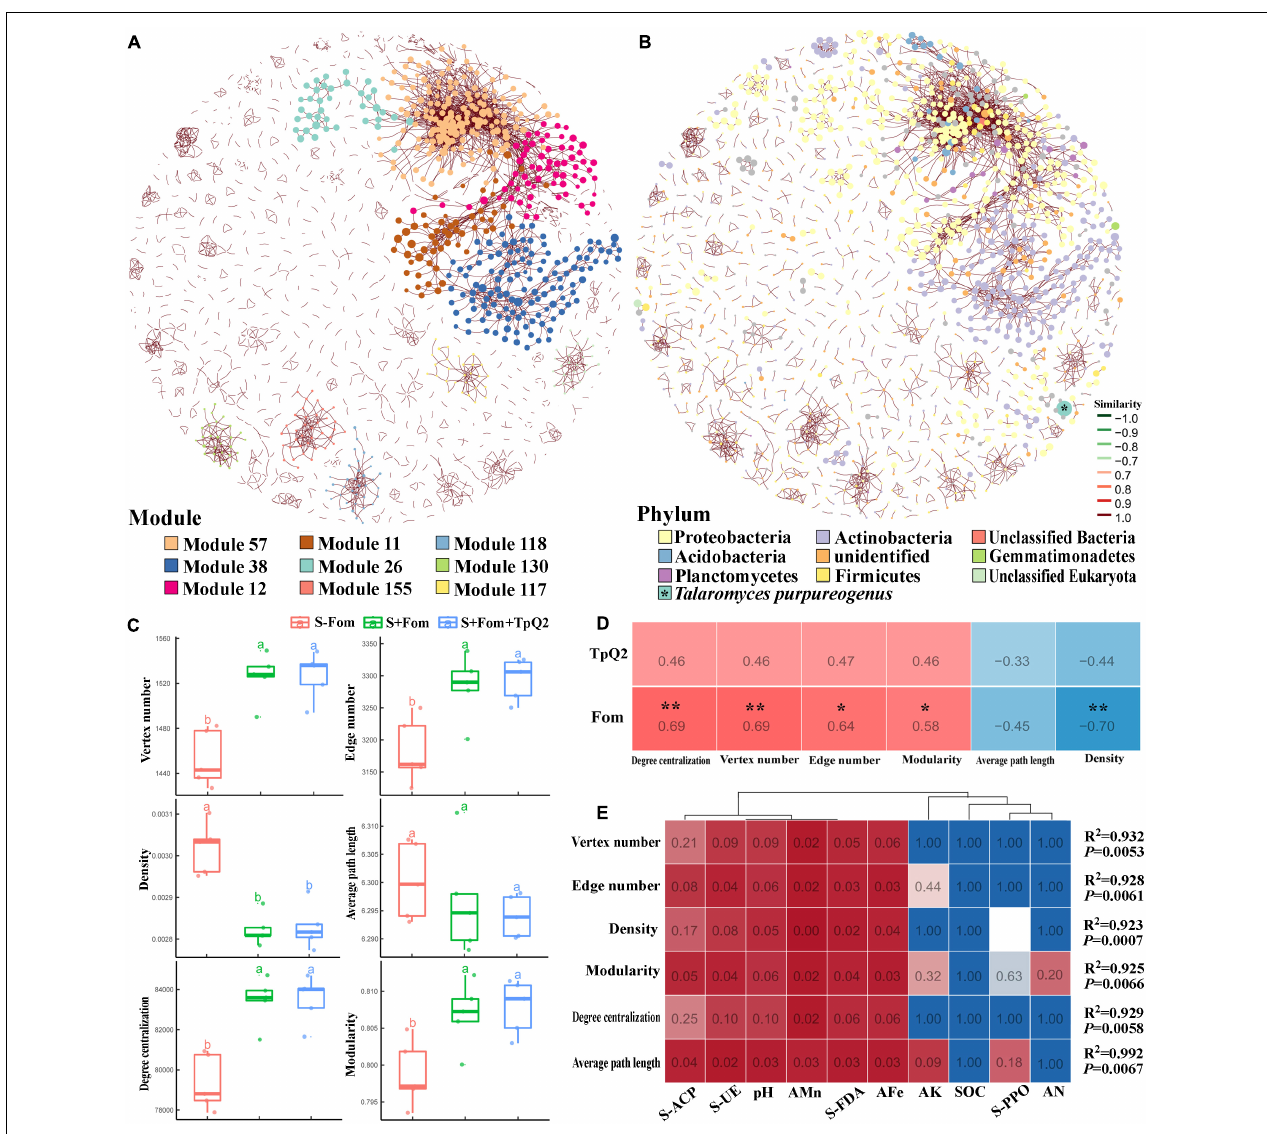
FIGURE 5 | Co-occurrence networks of soil microbe communities constructed using the S-Fom, S+FOM, and S+Fom+TpQ2 data set and the correlation analysis. (A) Co-occurrence networks showing the module associations among soil microbes. (B) Compositions of the networks at the phylum level. (C) Key topological features of the microbial networks. (D) Spearman’s correlation analysis of the key topological features and Fom, TpQ2. (E) Multiple stepwise regression analysis of the environmental limiting factors of key topological features of the co-occurrence networks. Different letters in the same column indicate significant statistical difference at P < 0.05 level determined using the Tukey’s honestly significant difference (HSD)